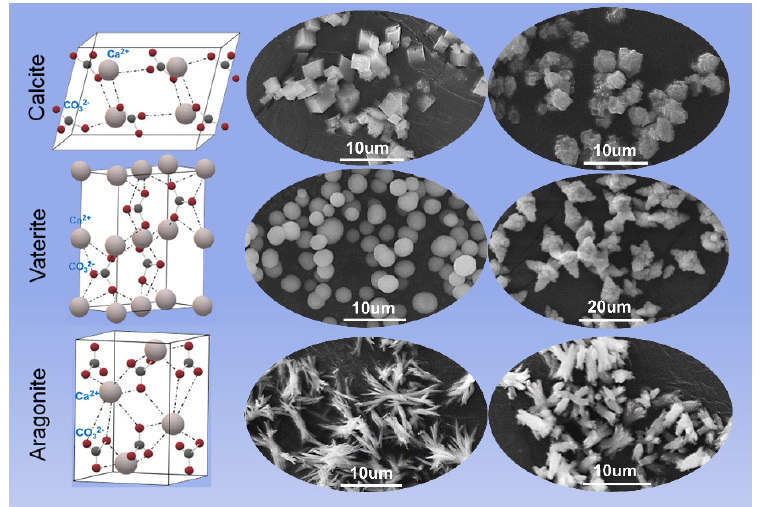
Figure 2. The crystal structure and macroscopic morphology (obtained from a scanning electron microscope (SEM)) of three crystalline phases of CaCO 3 particles: calcite ( top ), vaterite ( middle ), and aragonite ( bottom